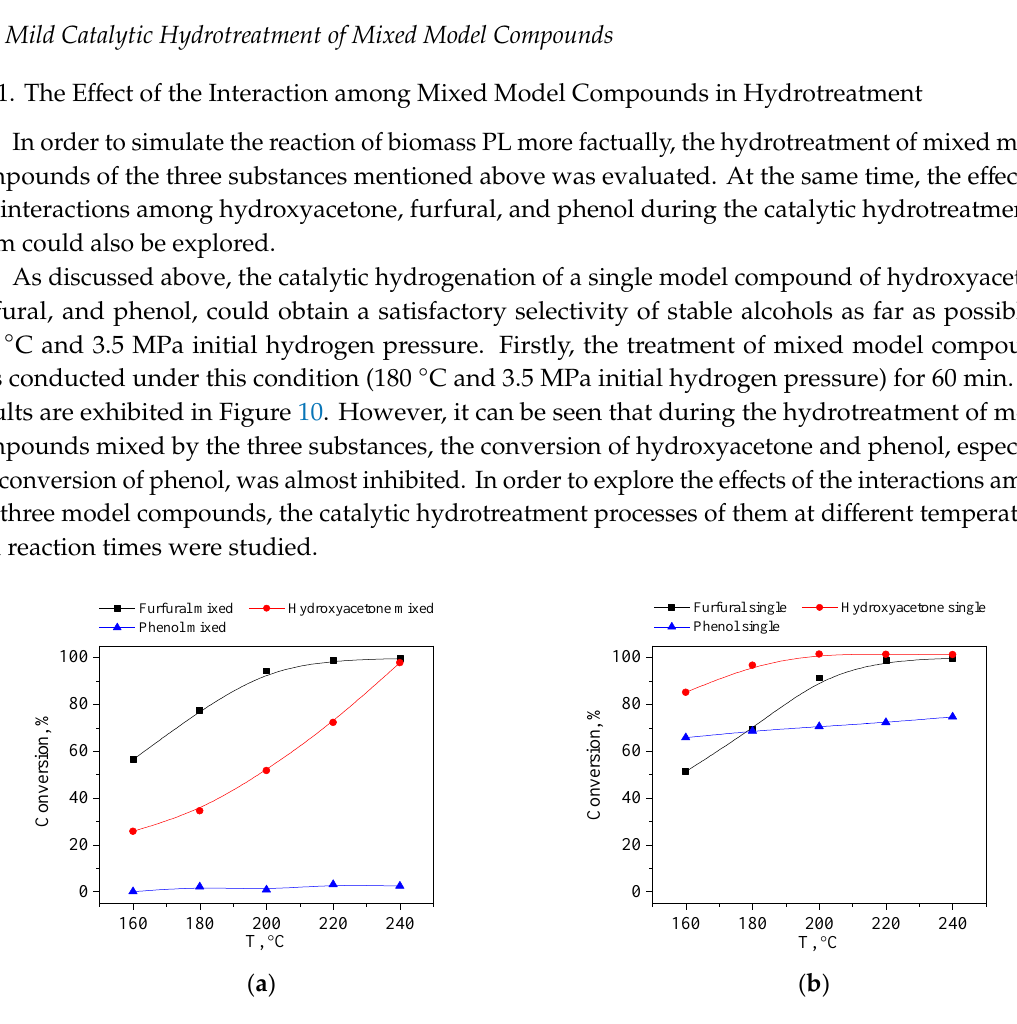
Figure 10. Effect of the reaction temperature on the conversion of furfural, hydroxyacetone, and phenol during the hydrotreatment of ( a ) mixed and ( b ) single model compounds (1 h, 3.5 MPa).